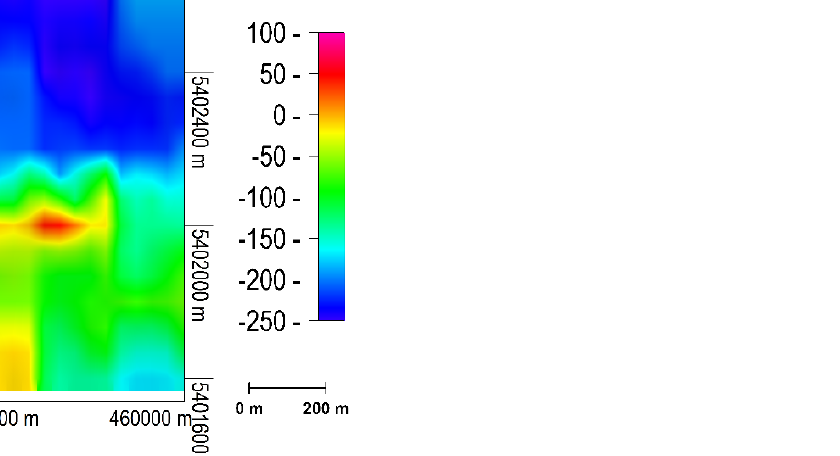
Figure 3. The Reid-Mahaffy test site. The figure shows a map of filtered TMI data.